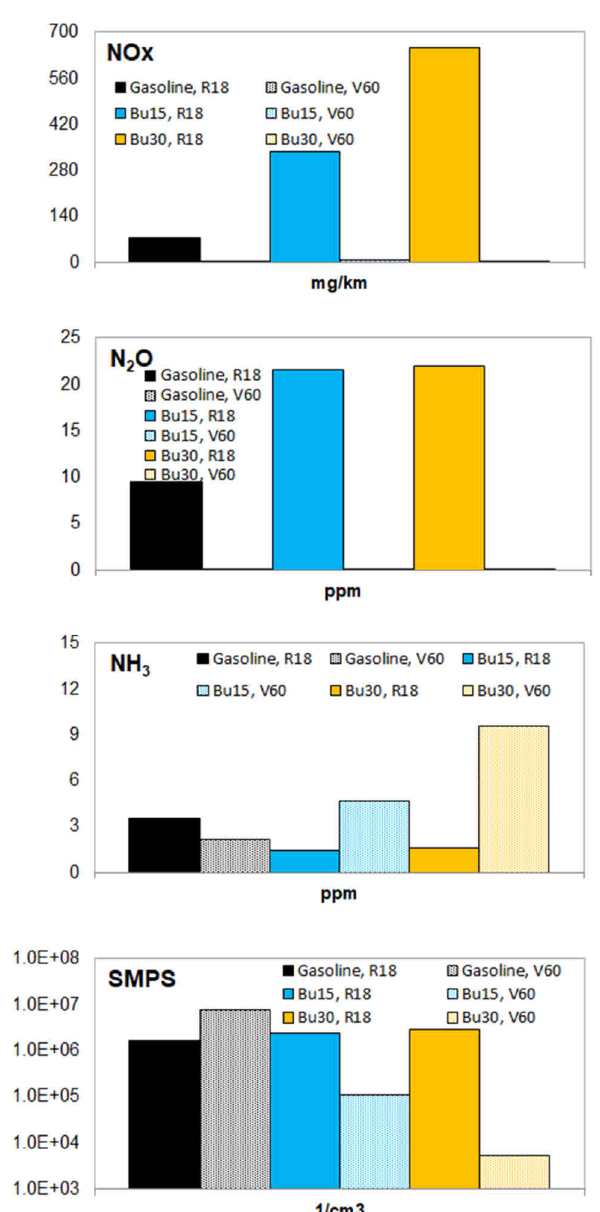
Fig. 8. Comparison of exhaust emissions of two vehicles at 95 km/h with different